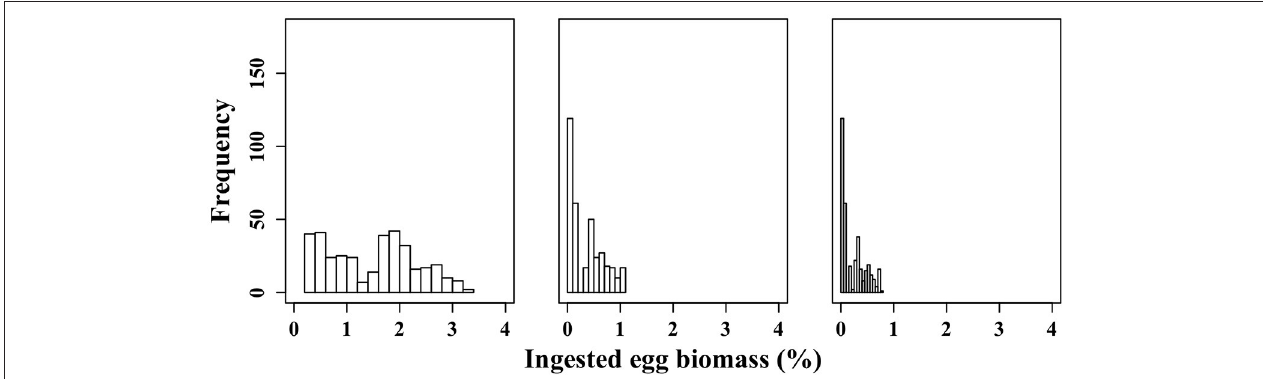
FIGURE 6 | Frequency distribution of the proportion of C. hyperboreus eggs standing stock ingested by female M. longa according to the minimal (0.6kg m − 3 ) (scenario D min ) (left panel), mean (19.4kg m − 3 ) (scenario D 0 ) (middle panel) and maximal C. hyperboreus egg density (26.8kg m − 3 ) (scenario D max ) (right panel).